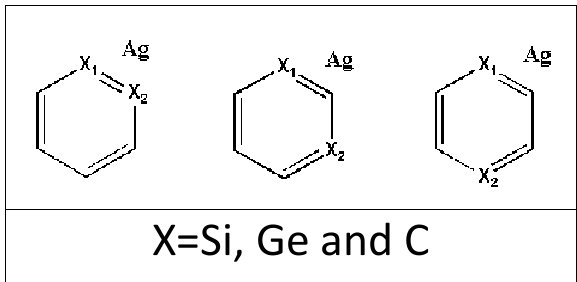
Fig. 2. The location and number of the dopant elements in the central ring of the graphene at three ortho, meta and para situations